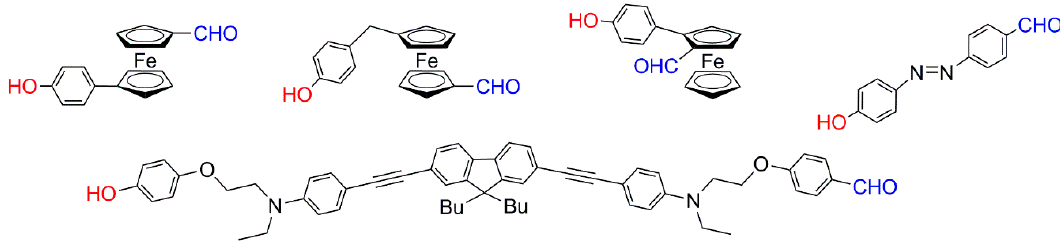
Figure 10. Examples of functional groups used at one or several layers inside the structure of phosphorhydrazone dendrimers, in replacement of